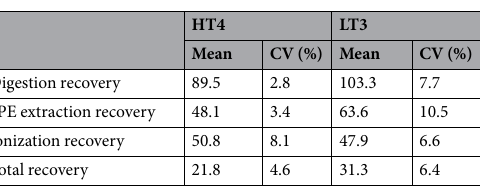
Table 2. Mean recoveries of LT3 and HT4 peptides in plasma samples. Mean recoveries were determined by measuring the peak area ratio of HT4 and LT3 peptides from a cetuximab digest spiked at 200 µ g/mL, before and after incubation with trypsin, SPE extraction and confronted to peak area ratios from a pure solution. Means are from 3 experiments. CV: Coefficient of